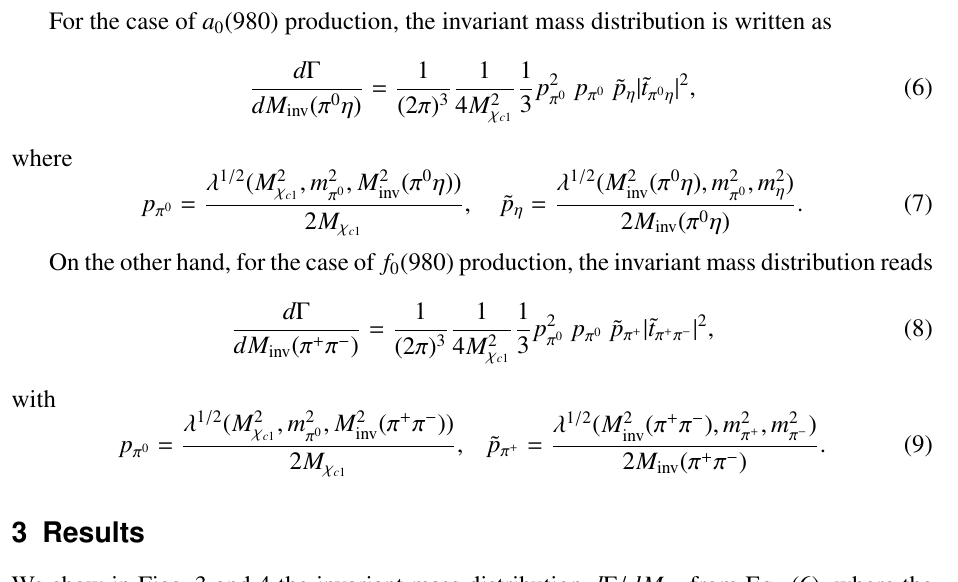
Figure 4. Zoom around the a 0 (980) peak in the invariant mass distribution of π 0 η in the χ → π 0 a → π 0 π 0 η reaction. (See text for c 1 0 (980)